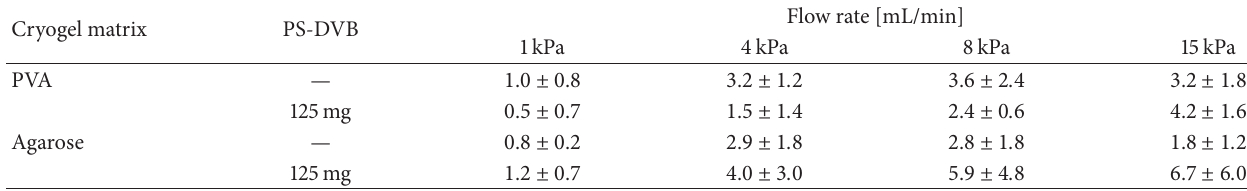
Table 1: Flow characteristics of particle-free and composite cryogels ( 𝑛 ≥ 4